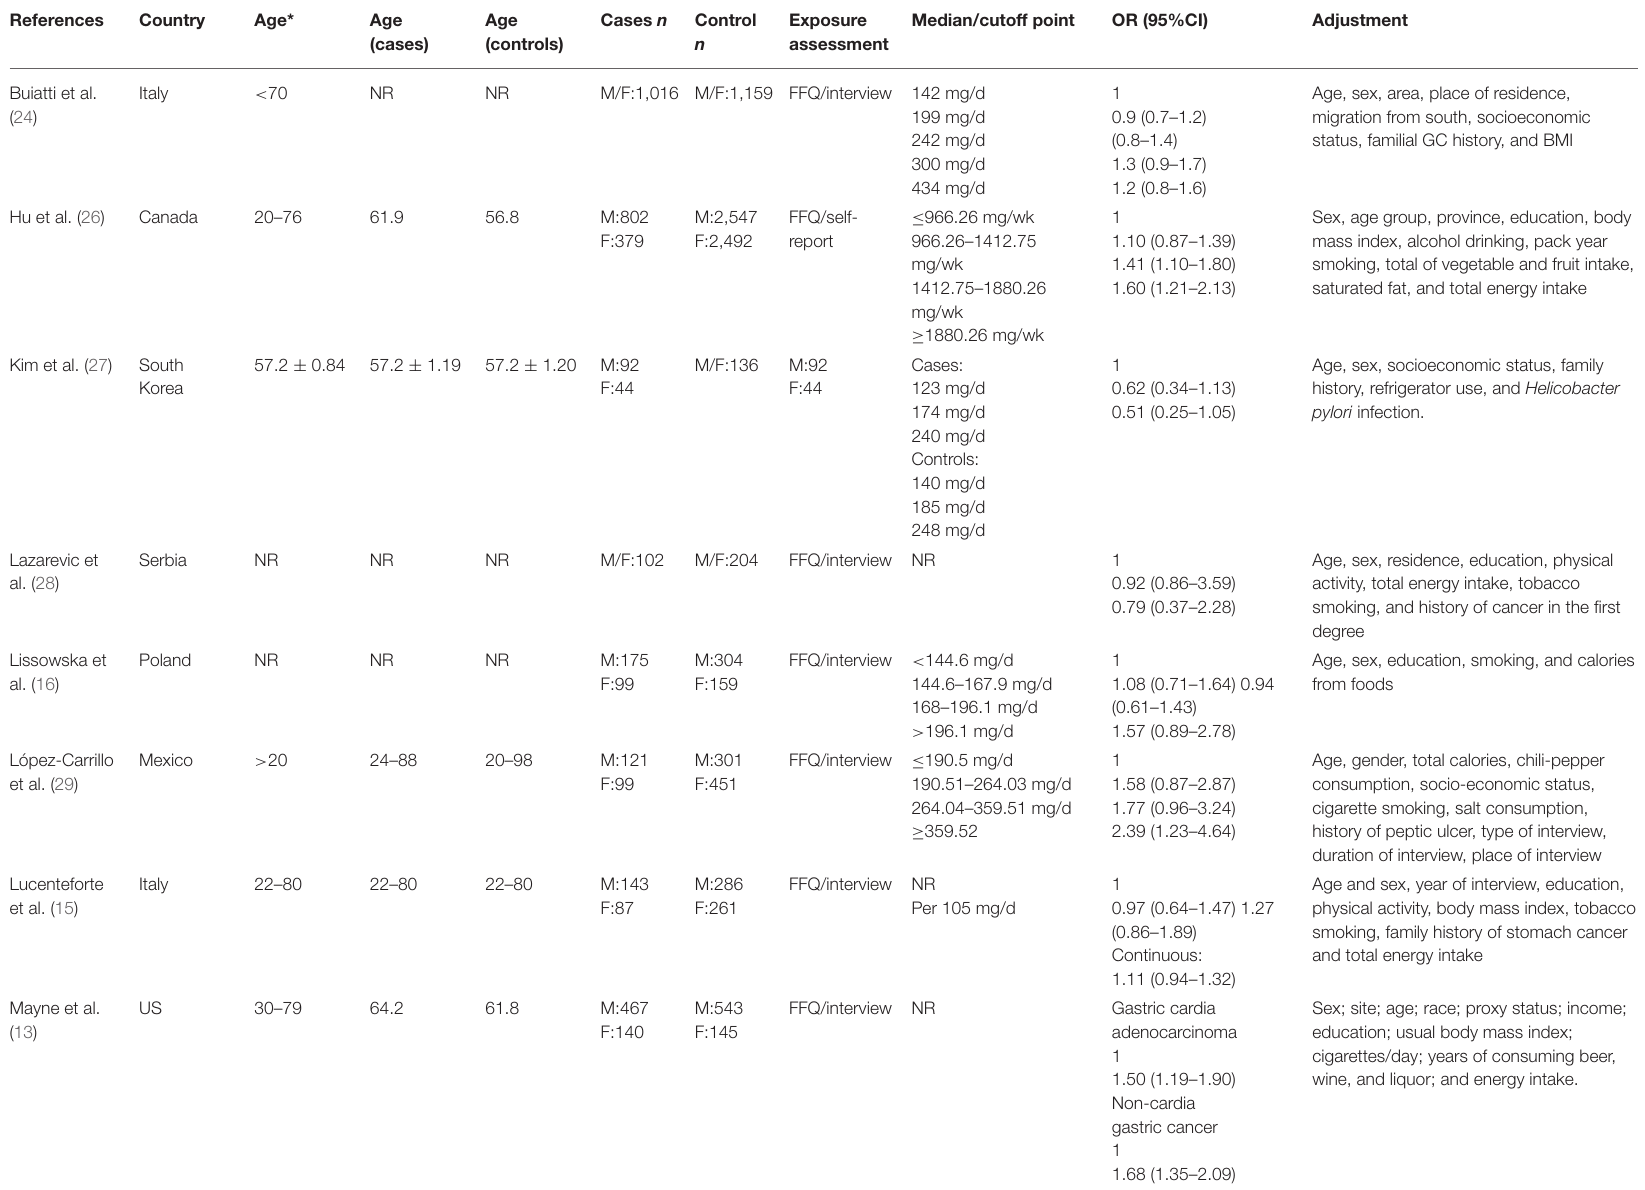
TABLE 1 | Characteristics of included studies on the association between cholesterol intake and gastric cancer in adults aged > 18 years in case-control